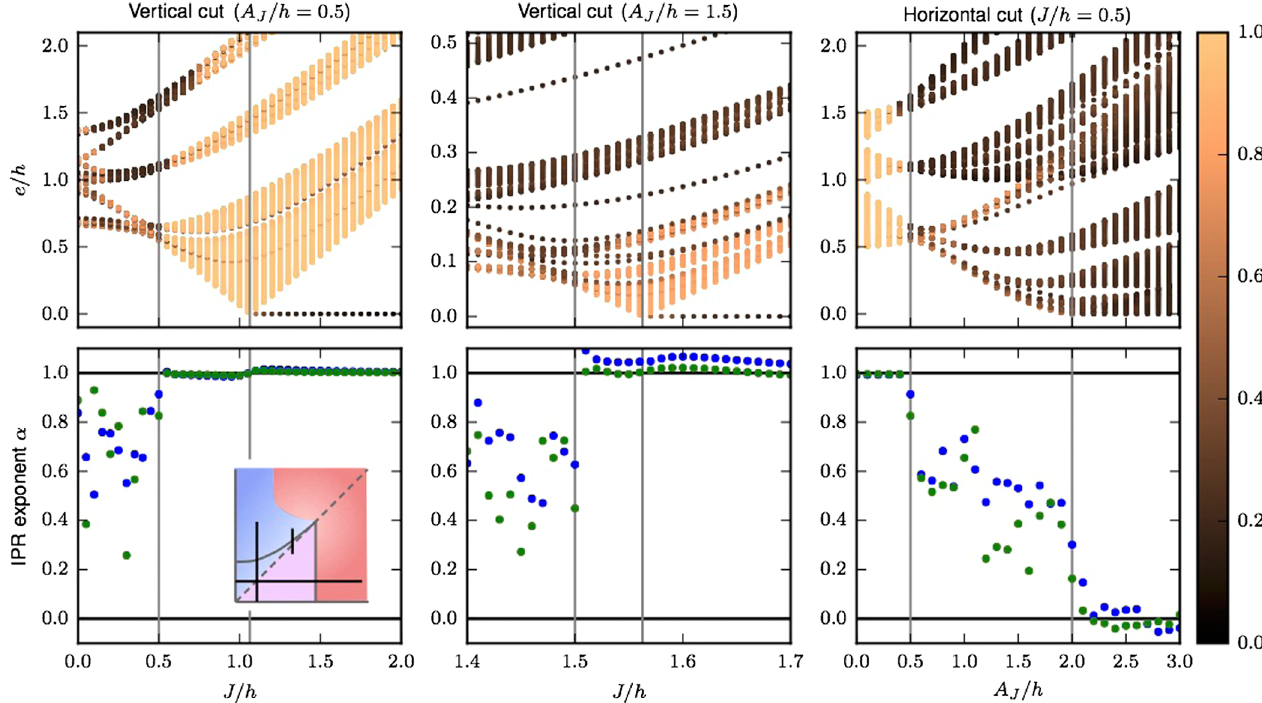
FIG. 5. Fermionic excitation spectra (upper row) and scaling exponent of low-energy IPR (lower row) on representative cuts in the phase diagram, indicated by black lines on the inset phase diagram. On each panel, vertical lines indicate the ground-state symmetry- J ) critically delocalized to extended boundary. (Upper row) Excitation spectra at size breaking phase boundary and the diagonal ( A J ¼ L ¼ 1000 . The color value of each level indicates the extension of the corresponding state. The color value is given by − log IPR = log L , which varies between 0 (localized, black) and 1 (extended, copper). (Lower row) The IPR exponent α is defined by the scaling ½ log IPR (cid:2) ∼ − α log L , where the mean ½ · (cid:2) is taken over the lowest twentieth of the excitations. Here, α varies between 0 (localized) and 1 (extended). To indicate the finite-size trends approaching the thermodynamic limit, we fit data from both L ¼ 100 , 200, 350, 500, 750, 1000 (blue) and L ¼ 350 , 500, 750, 1000